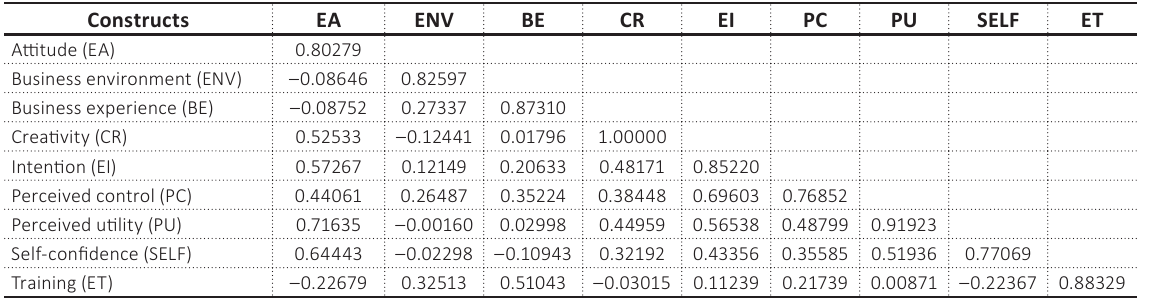
Table A6. Fornell-Larcker